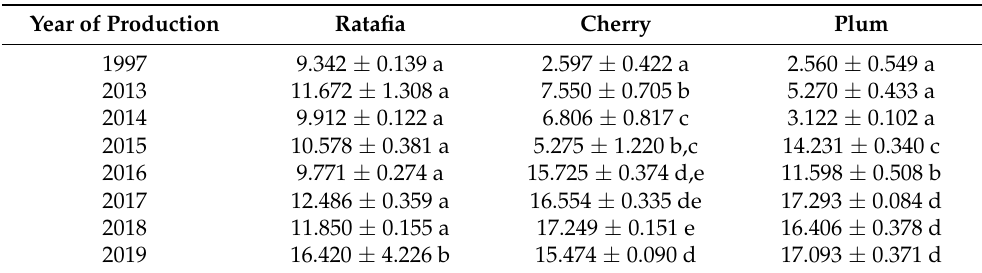
Table 2. The antioxidant activity of nalewkas was measured by the ABTS method (mean ± SD, n = 3). Different letters indicate significant differences between the individual years. The result was expressed in mg Trolox · g − 1 of nalewka.